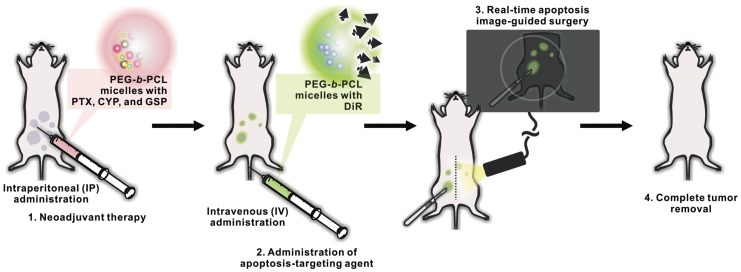
Schematic illustration of two-step strategy for neoadjuvant therapy, apoptosis-targeted optical imaging and intraoperative surgical guidance, enabled by a tandem of PEG-b-PCL micelles.